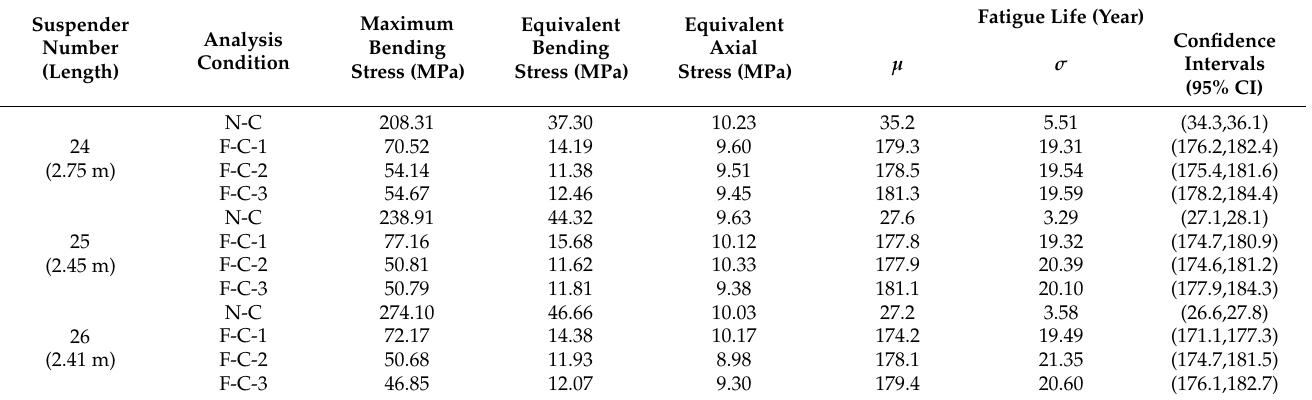
Table 4. Fatigue life of suspender wire under different analysis